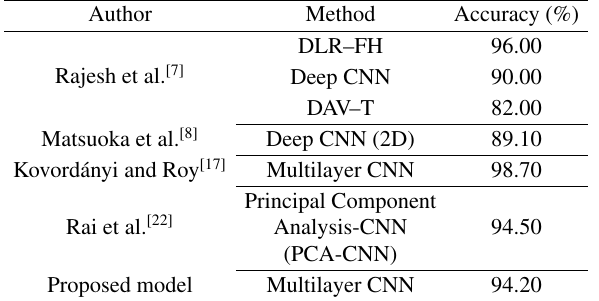
Table 3 Comparison of the proposed model with other state- of-the-art